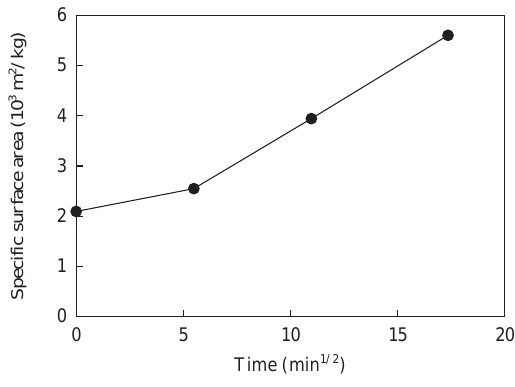
Relation between specific surface area and grinding time